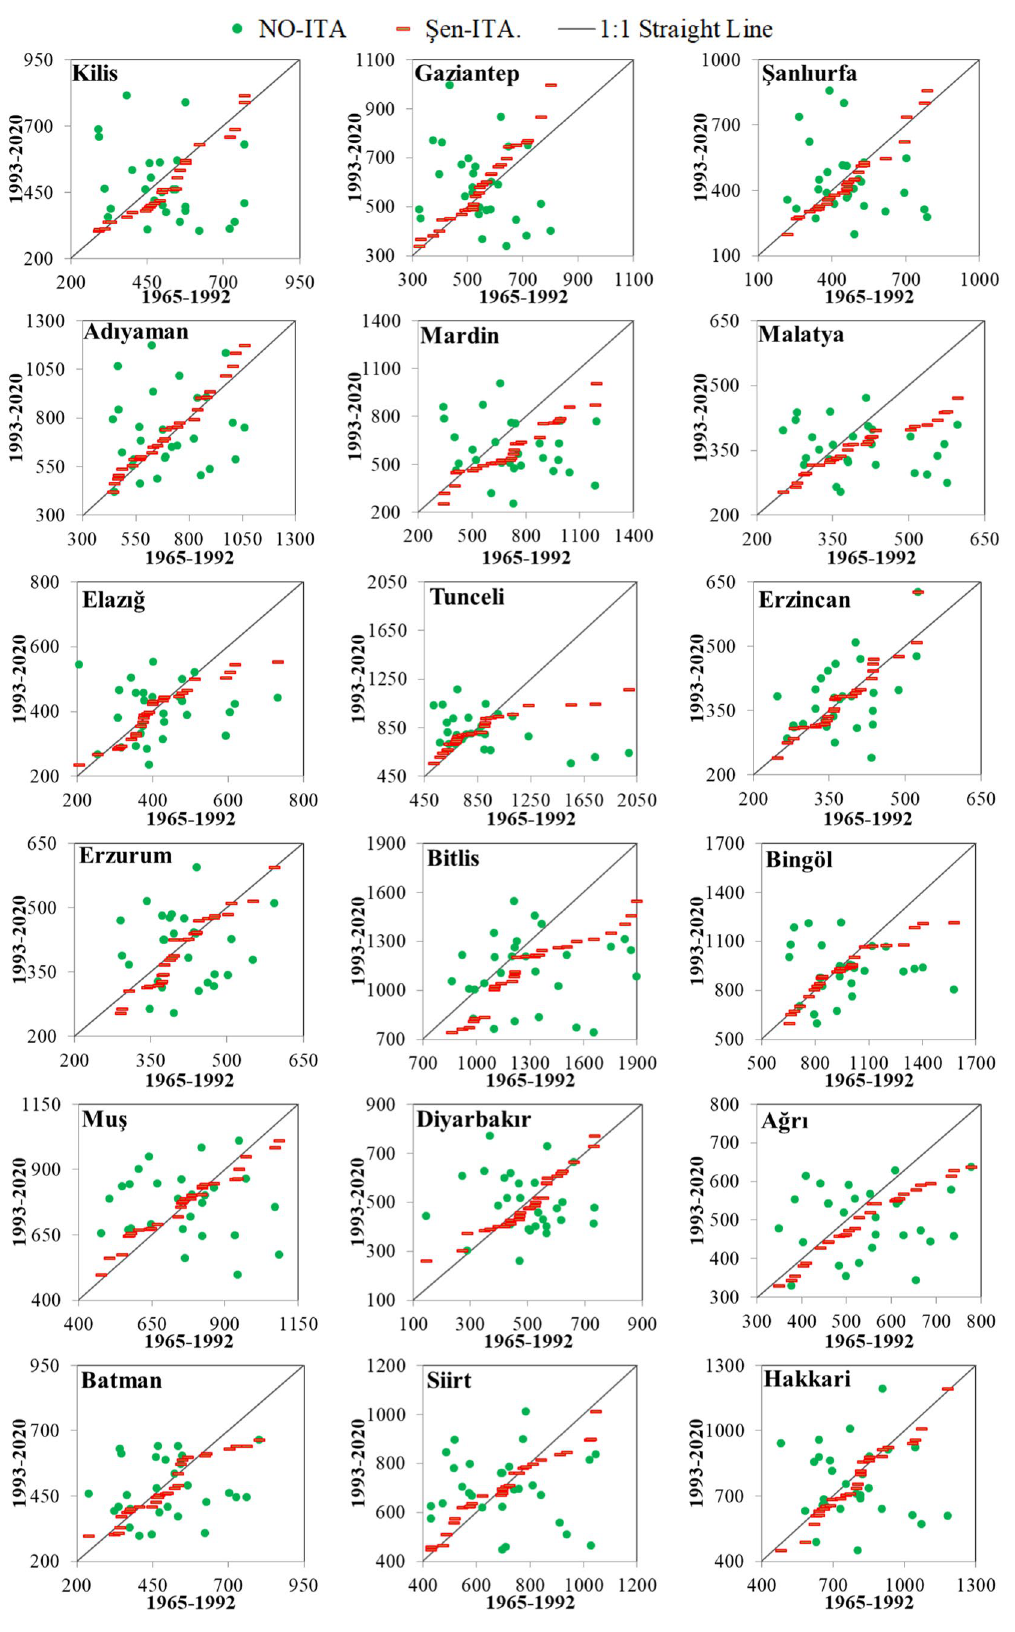
Fig. 6 Şen-ITA and NO-ITA